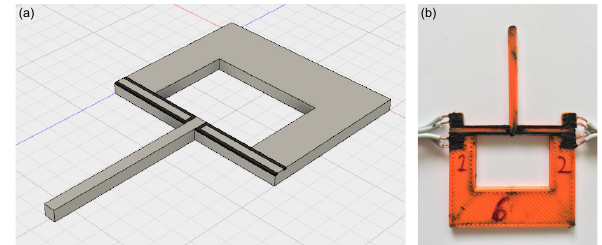
Figure 15. Panel (a) shows a CAD drawing of the co-printed tactile sensor. The black part is conductive. Panel (b) shows the printed version with molten connections (Eijking et al.,